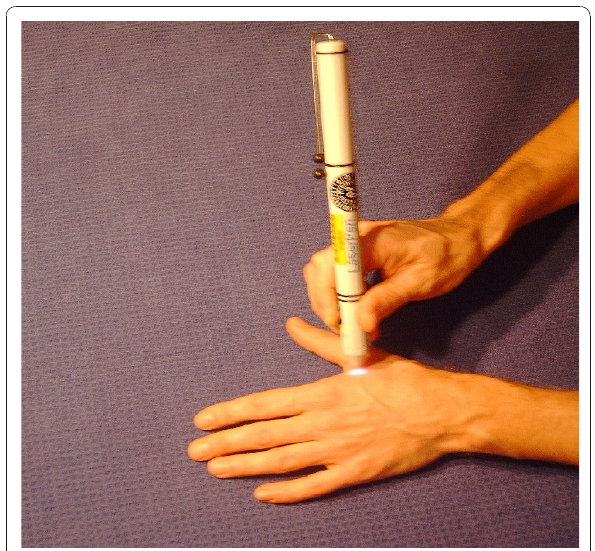
Figure 1 Sham laser device . In the device used during sham laser acupuncture, laser irradiation was deactivated by the manufacturer (Seirin, 3B Scientific GmbH, Hamburg, Germany). The visual (red light, approximately 587 nm) and acoustic functions were maintained and therefore double-blinding was